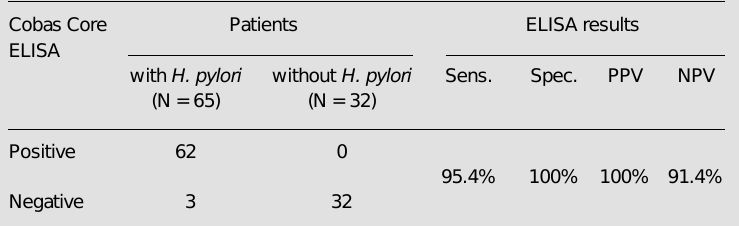
Table 2 - Sensitivity, specificity, and predictive values of Cobas Core ELISA in 97 patients undergoing endoscopy. Sens., Sensitivity; Spec., specificity; PPV, positive predictive value; NPV, negative predictive